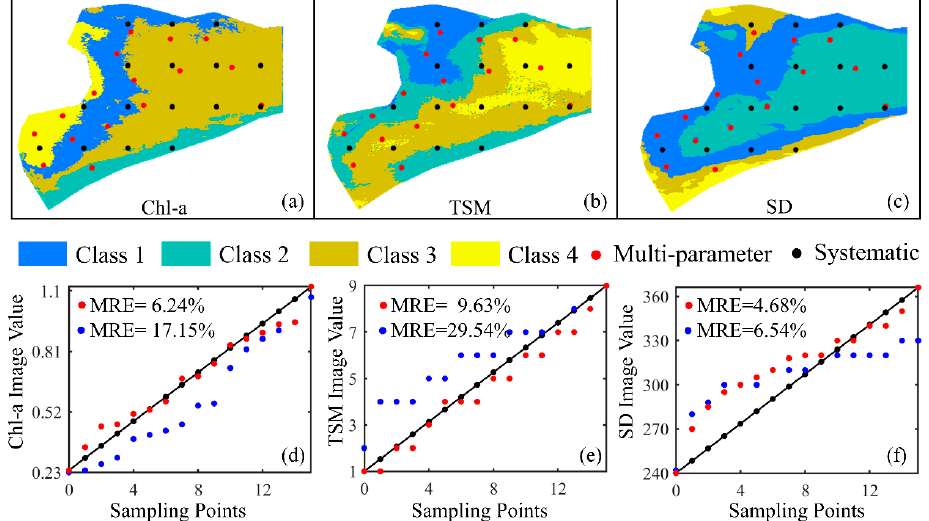
Figure 10. There are multi-parameter sampling points in Bosten lake ( a–c ) and the MRE of the in-situ and simulated data ( d–f ). Black dots are simulated data, red dots are adaptive weight sampling points, and blue dots are system sampling points.